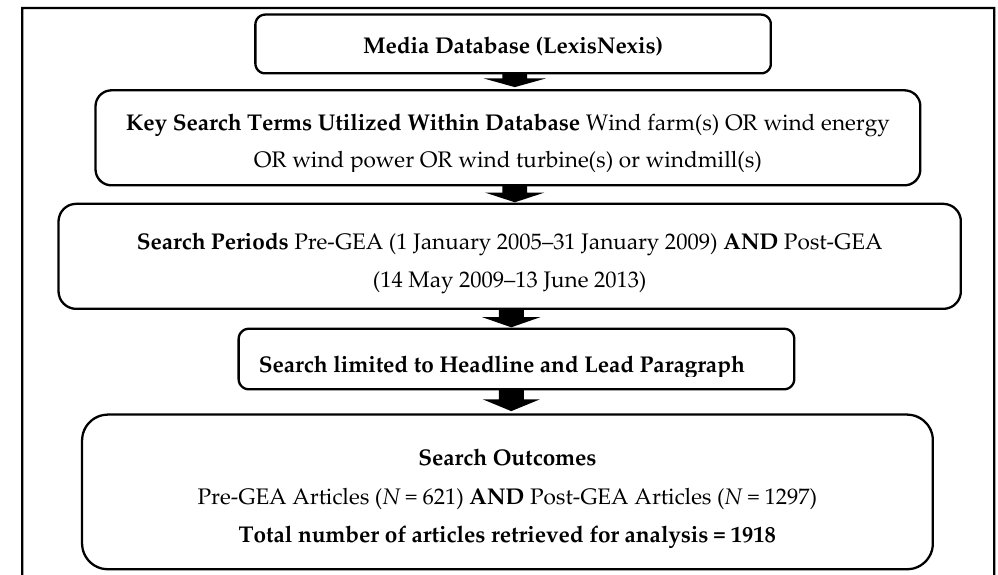
Figure 2. Summary of sampling protocol in LexisNexis. GEA, Green Energy Act.